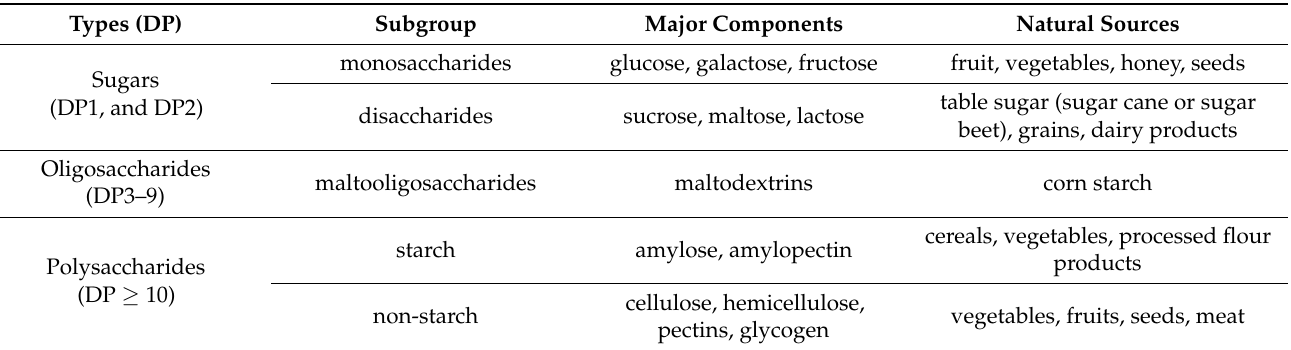
Table 1. Classification of dietary carbohydrates. Saccharides are classified according to degree of polymerization (DP) by indication of the length of the carbohydrate chain. The sugar term includes the sum of all the mono- and di-saccharides (DP1, and DP2). Higher DPs classified as carbohydrates, such as oligo- and polysaccharides. Functional and structure divisions include subgroups with major dietary components and main natural sources.